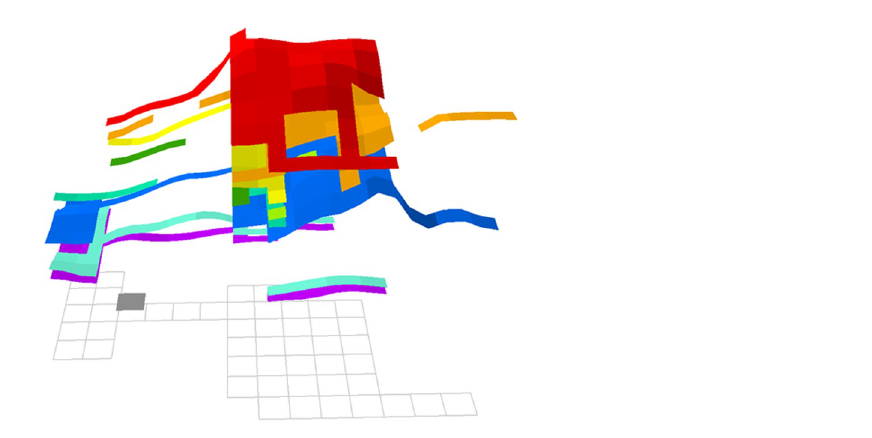
Fig 3. Tridimensional GIS model of the distribution of Smith’s levels at Ganj Dareh. The supplementary figure includes an animated version of this model.